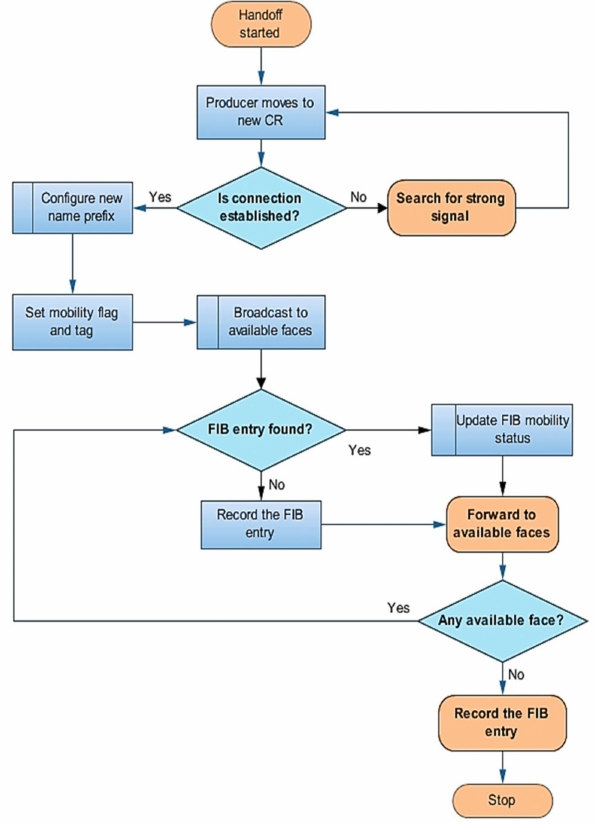
Figure 3. Mobility update by broadcasting